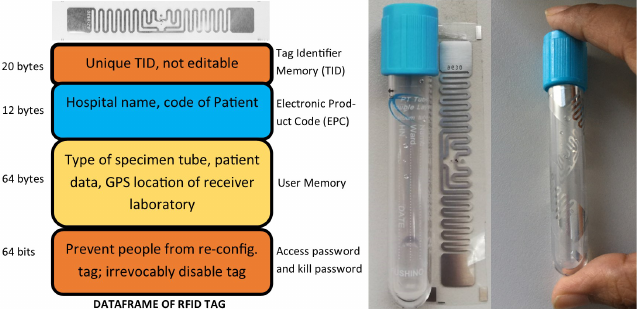
Figure 3. The passive RFID tag EPCglobal Gen2 used in our study [31]. The tag does not